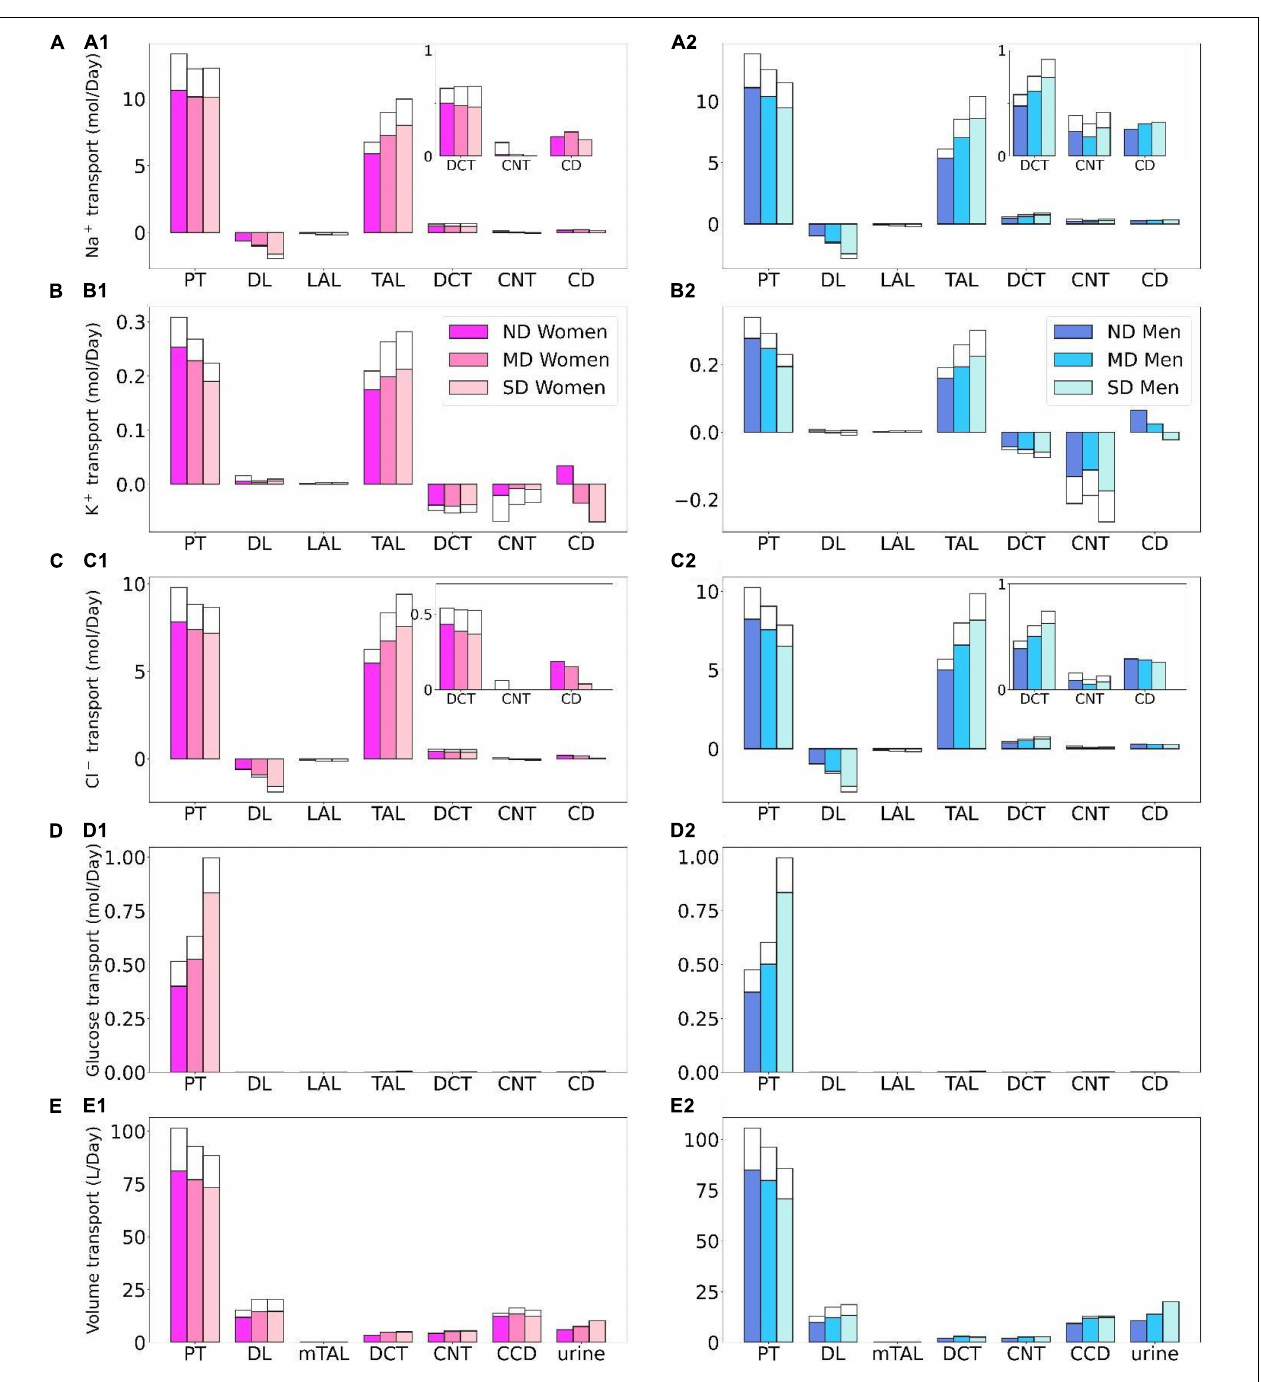
FIGURE 6 | Transport of Na + (A) , K + (B) , Cl – (C) , glucose (D) , and fluid (E) along individual nephron segments in women and men without ND, with MD, and with SD under SGLT2 inhibition. Notations are analogous to Figure 2 . PT, proximal convoluted tubule and S3.